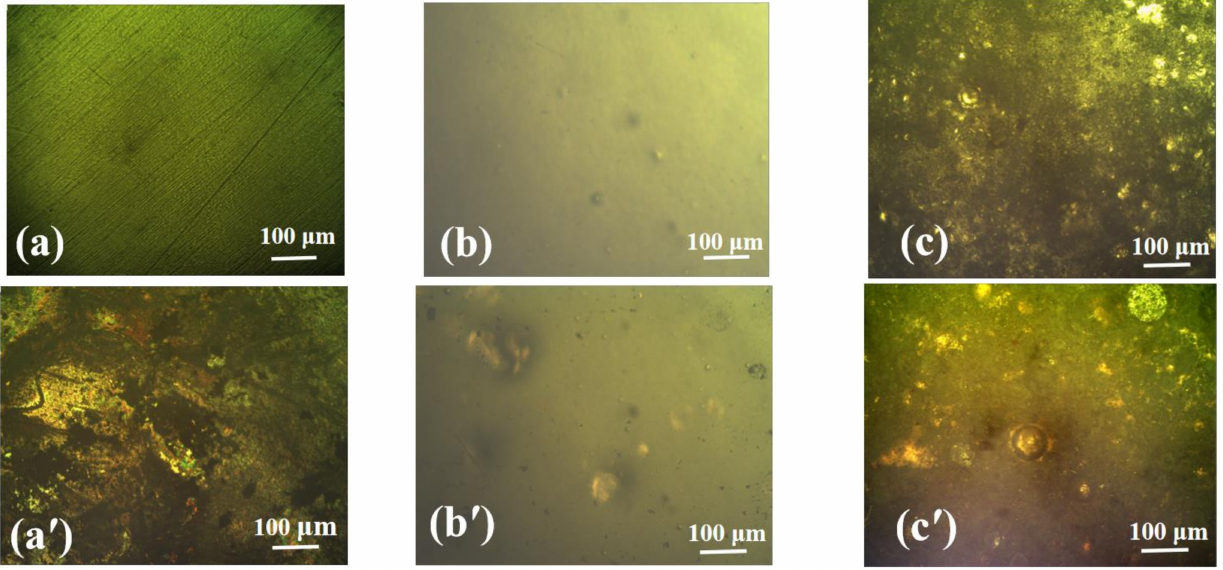
Figure 5. Metallographic images in different corrosion condition: ( a , a (cid:48) ) for specimen #1 before/after corrosion; ( b , b (cid:48) ) for specimen #2 before/after corrosion; ( c , c (cid:48) ) for specimen #3 before/after